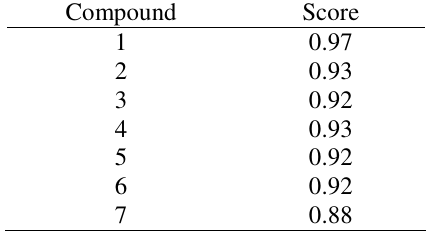
Table 2. Alignment scores of compounds 1-7 with ent -kaurenoic acid